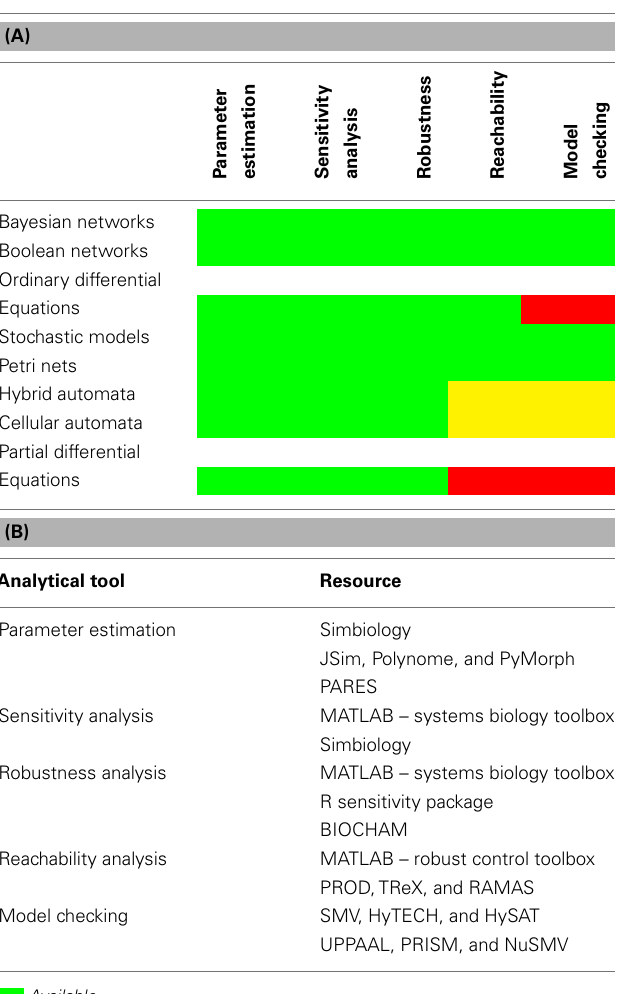
Table 1 |Tools tables . (A) A table of references for the use of each analytical tool in each model type, where available.The colors denote availability, as specified in the legend. (B) A (non-exhaustive) table of available implementations of analytical tools described in the previous